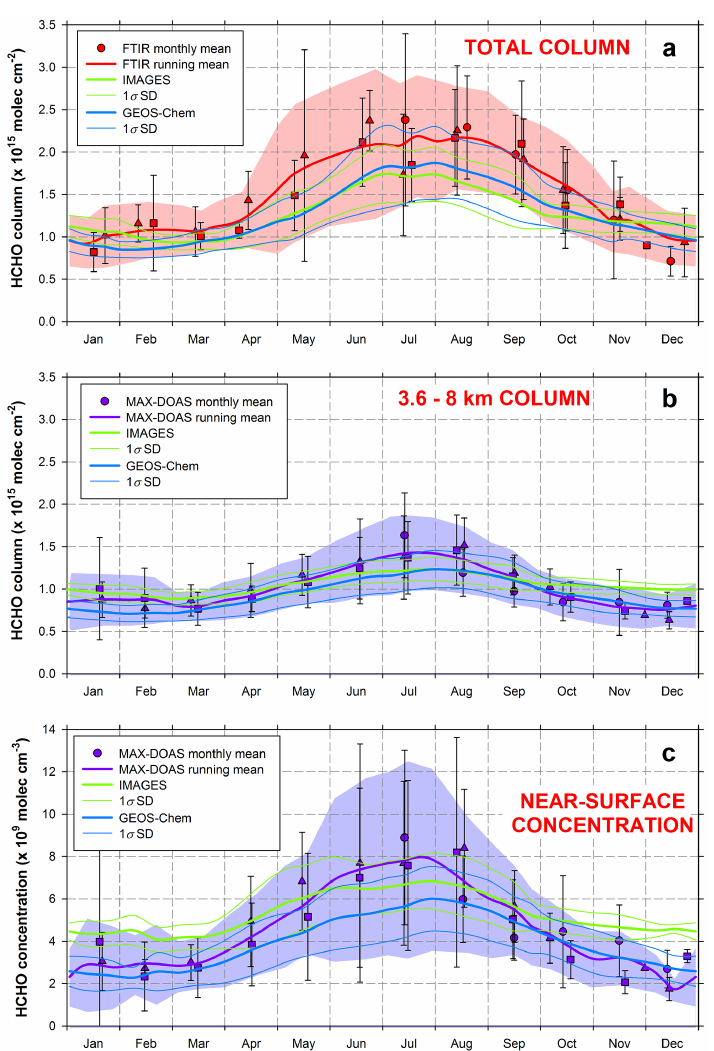
Figure 4. Monthly-mean column abundances of HCHO and associated 1 σ SD bars displayed on a 1-year time base, according to the FTIR and MAX-DOAS retrievals ( a and b , respectively) above Jungfraujoch from July 2010 to December 2012. The circle, triangle and square dots correspond to the monthly means from 2010, 2011 and 2012, respectively. The thick curves correspond to a running mean fit to the daily-mean columns displayed on a 1-year time base (not shown here), with a 15-day step and a 2-month-wide integration time. The shaded areas represent the 1 σ SD associated with the running mean curves. As it is calculated on the basis of the daily-mean columns, this 1 σ SD convolves interannual variability and variability of the monthly mean. Note that the FTIR abundances correspond to total columns and the MAX-DOAS data consist of partial columns within the 3.6–8km altitude range. The HCHO amounts calculated from the smoothed CTM profiles are displayed in each frame as running mean fit (solid thick curve) and the associated 1 σ SD (thin line). A similar figure, but for the HCHO concentration derived from MAX-DOAS and the CTMs within the 3.6–8km near-surface layer, is drawn in ( c